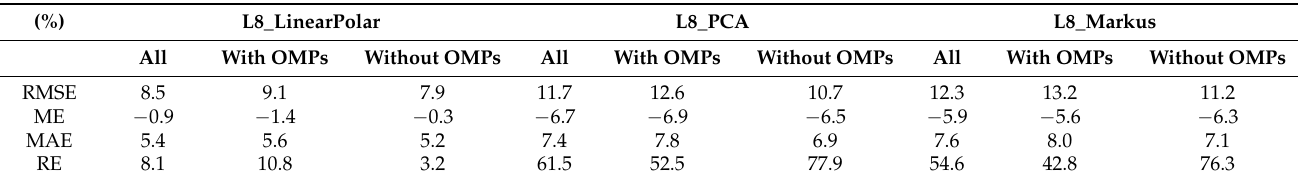
Table 7. The errors of the average MPF for 80 cases between the 3 algorithms for the L8 data and LinearPolar for the S2 data.